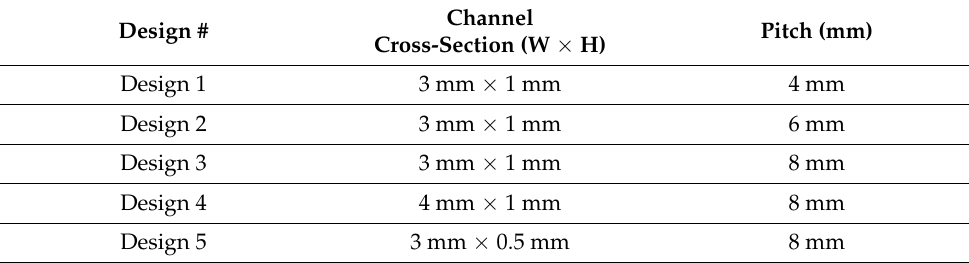
Table 1. Spiral microfluidic configuration scenarios used for